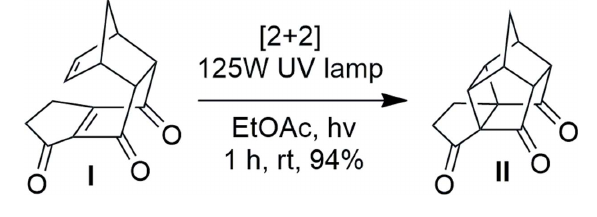
Figure 2 [2 + 2] photocycloaddition of Diels–Alder adduct